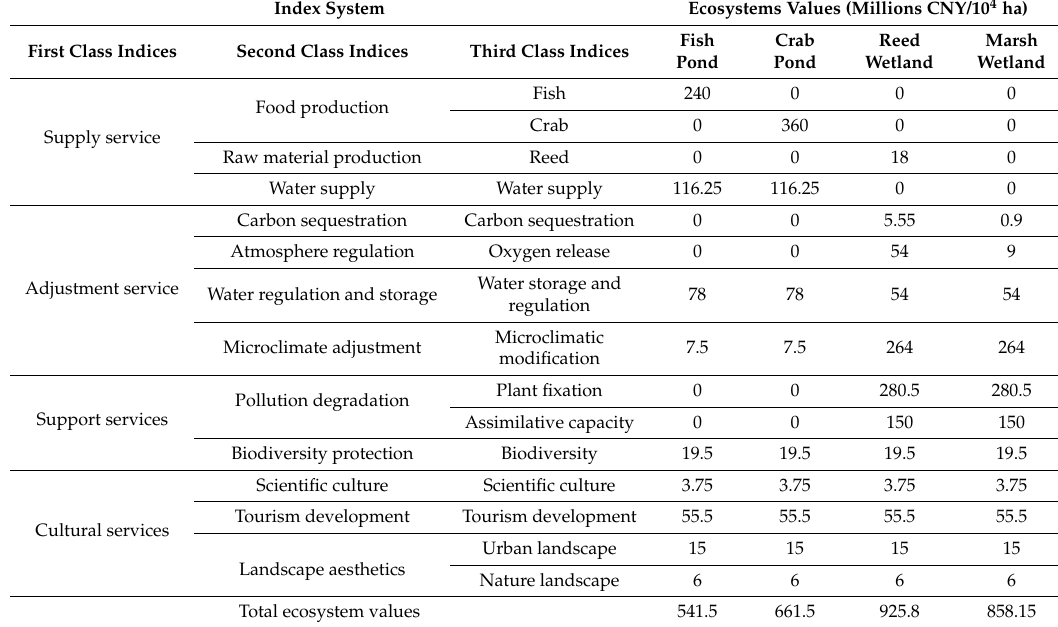
Table 3. Assessment index system for the incremental value of ecological services in western Jilin